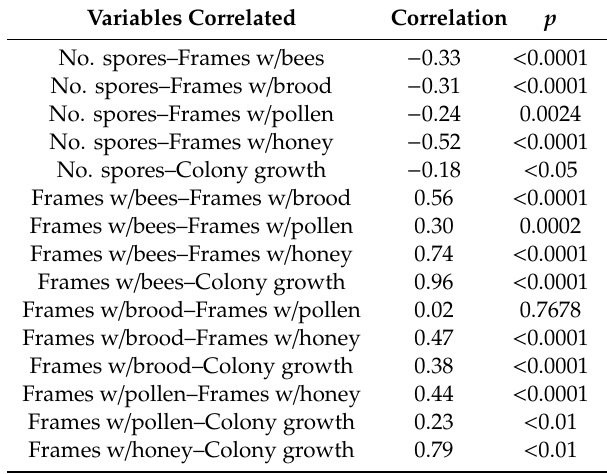
Table 3. Correlations between infection intensity of Nosema ceranae (No. spores / bee), colony growth, populations, and stored food of honey bee colonies ( n = 151).